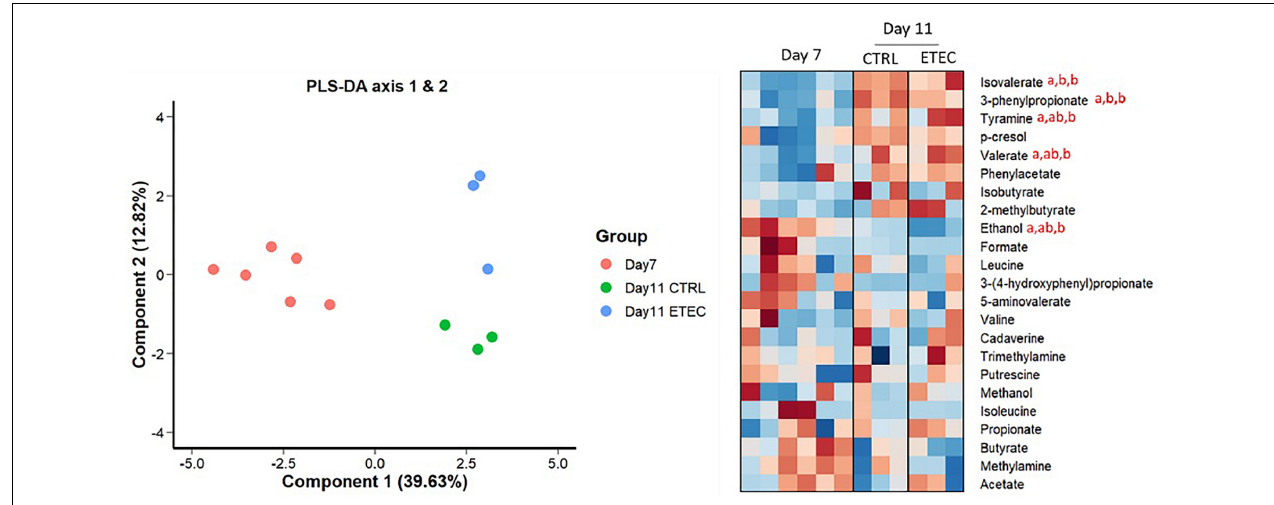
FIGURE 3 | NMR-based metabolomics analysis of mucin bead medium. Left panel: Individual plot of PLS-DA. Right panel: Heatmap representing the relative concentrations of all identified metabolites (rows) in individual samples (columns). The color represents the Z-scores (row-scaled relative concentration) from low (blue) to high values (red). The days sharing the same letters are not significantly different from each other ( p > 0.05) whatever the